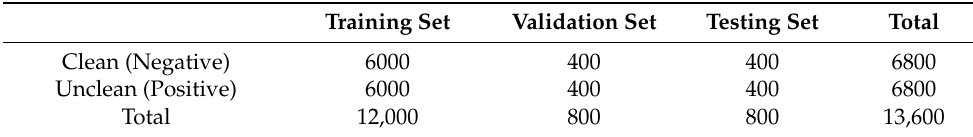
Table 3. Configuration of the training, validating, and test datasets.